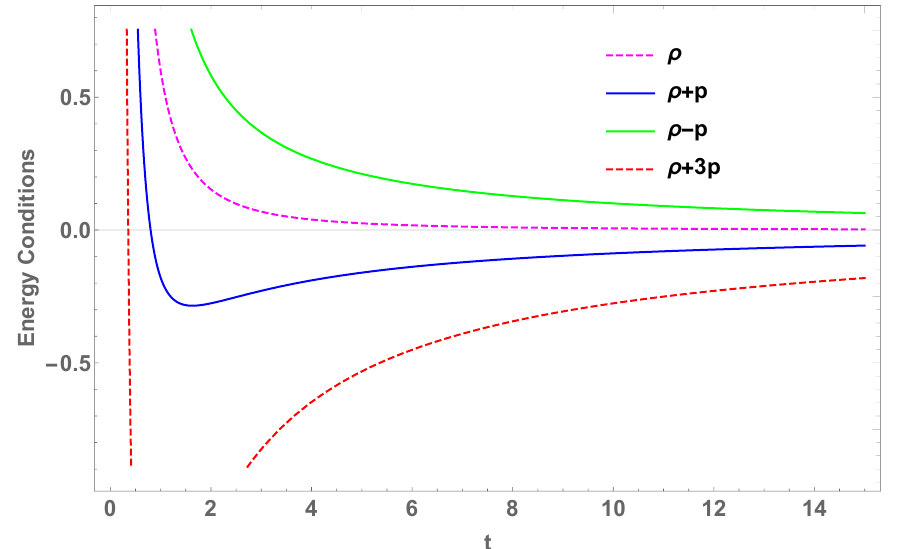
Figure 9. Behaviour of the energy conditions with respect to cosmic time t for β = − 5.0, α = − 1.5, b = 0.2.